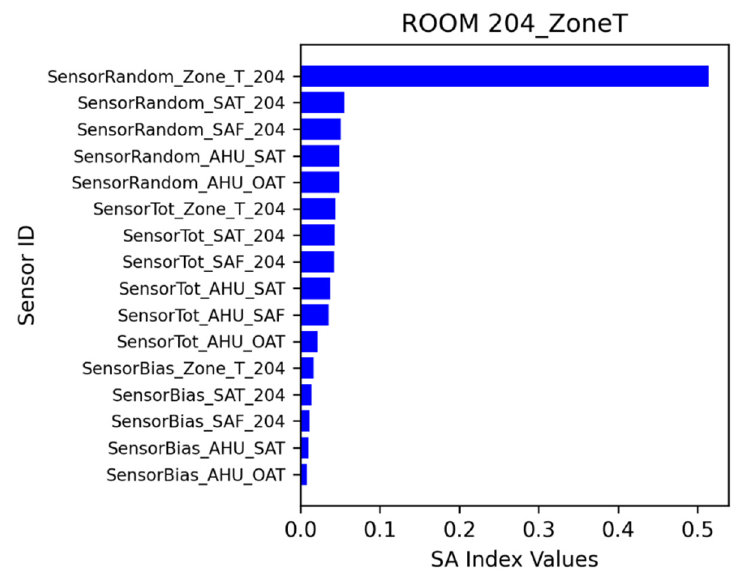
Figure 20. SA for zone 204 air temperature.